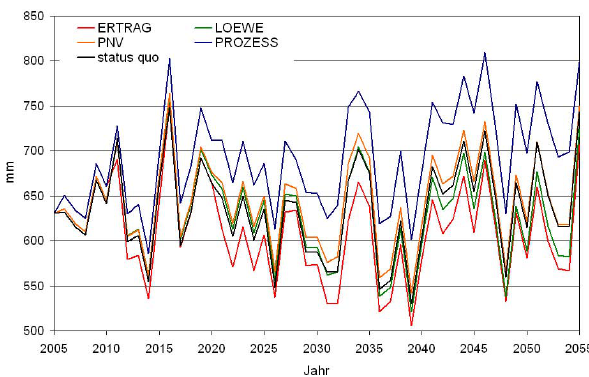
Fig. 4. Simulated actual evapotranspiration for different forest de- velopment scenarios. Table 1. Water budget components calculated (in mm/a) for dif- ferent forest development scenarios, mean values for the